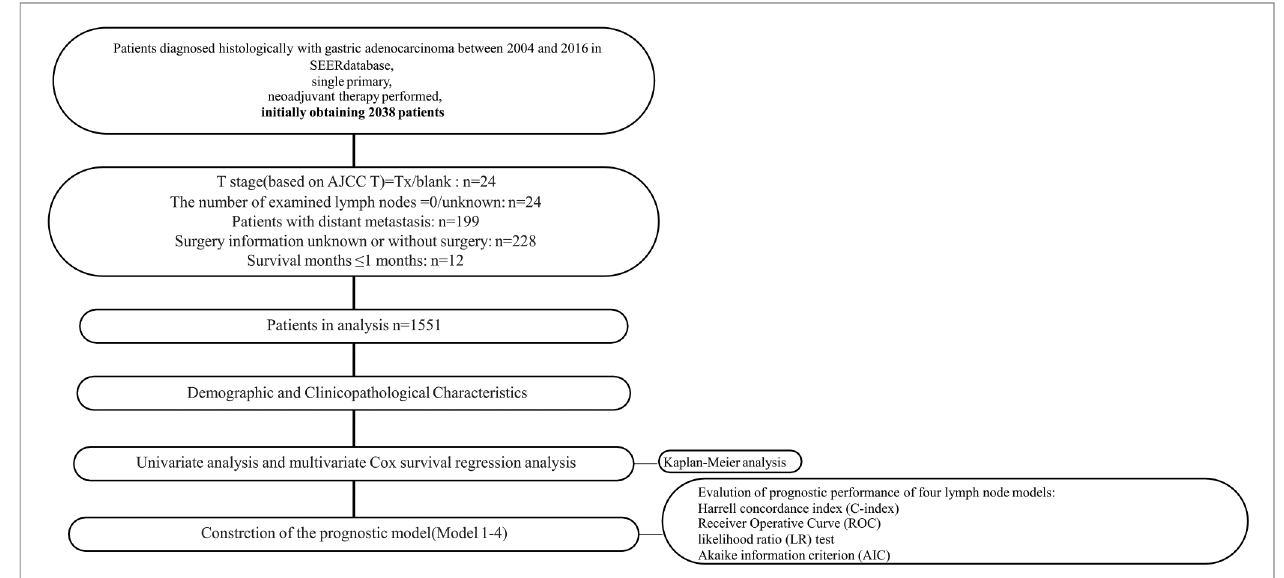
FIGURE 1 | Research fl